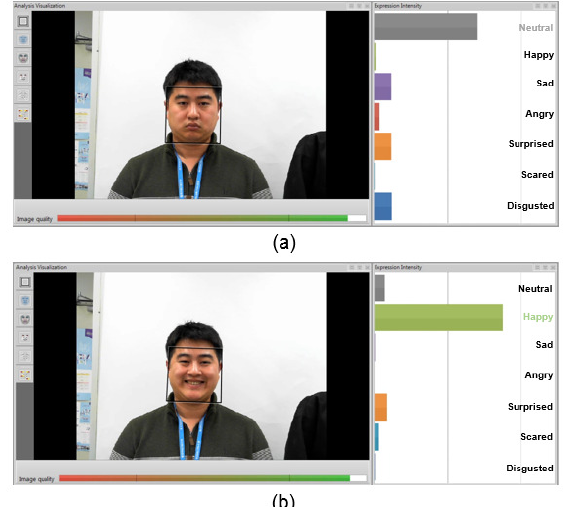
Figure 5. Results of human facial expression recognition using FaceReader for ( a ) a Neutral expression and ( b ) a Happy